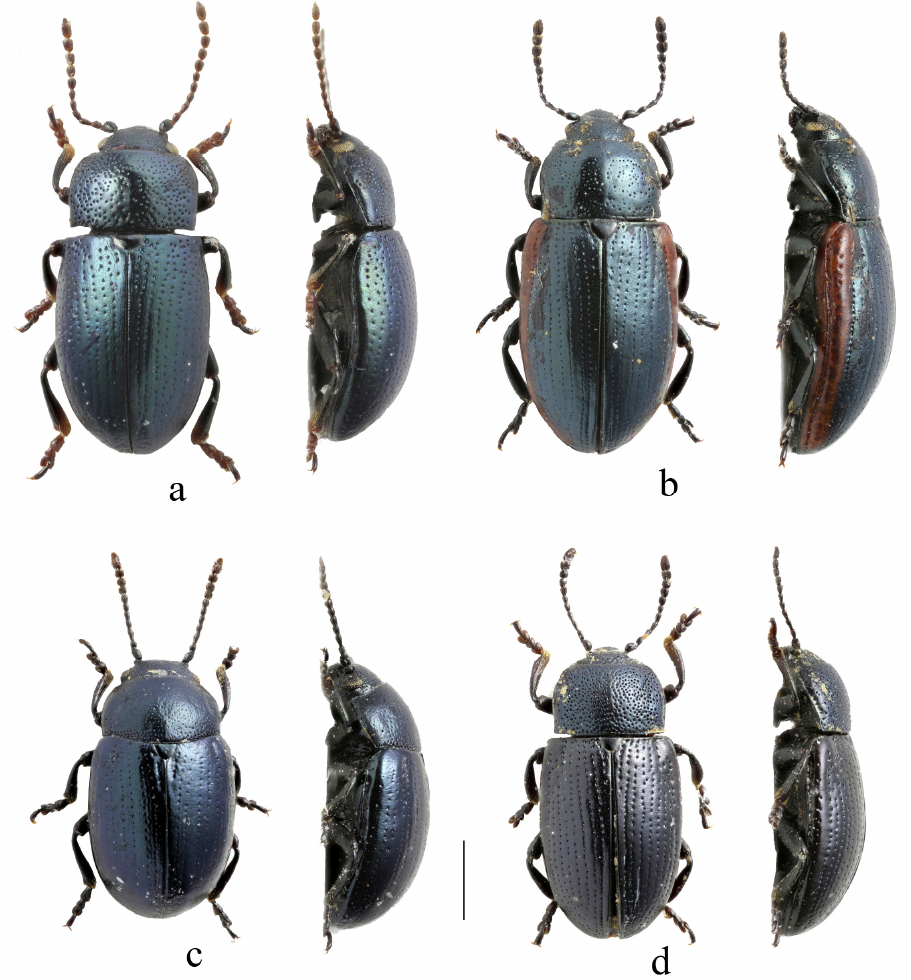
Figure 2. Habitus of adult beetles in dorsal and lateral view: ( a )— Apterocuris sibirica Jacobson, 1901, male (East Kazakhstan, Prokhodnoy Belok Mts.); ( b )— Oreothassa martjanowi Jacobson, 1901, female (Russia, Kemerovo Region, Kuznetsky Alatau Mts.); ( c )— Sternoplatys clementzi Jacobson, 1901, male (Russia, Tyva Republic, Mongun-Taiga Massif); ( d )— Oreothassa weisei (Reitter, 1901), male (Russia, Altai Republic, Iolgo Mt. Range). Scale bar—1 mm. Underside: prothoracic hypomera almost flat and shagreened, densely covered with coarse punctures; prosternal process broad, apically widened and truncate, with coarse and dense punctures. Metaventrite with dense and coarse punctures; abdominal